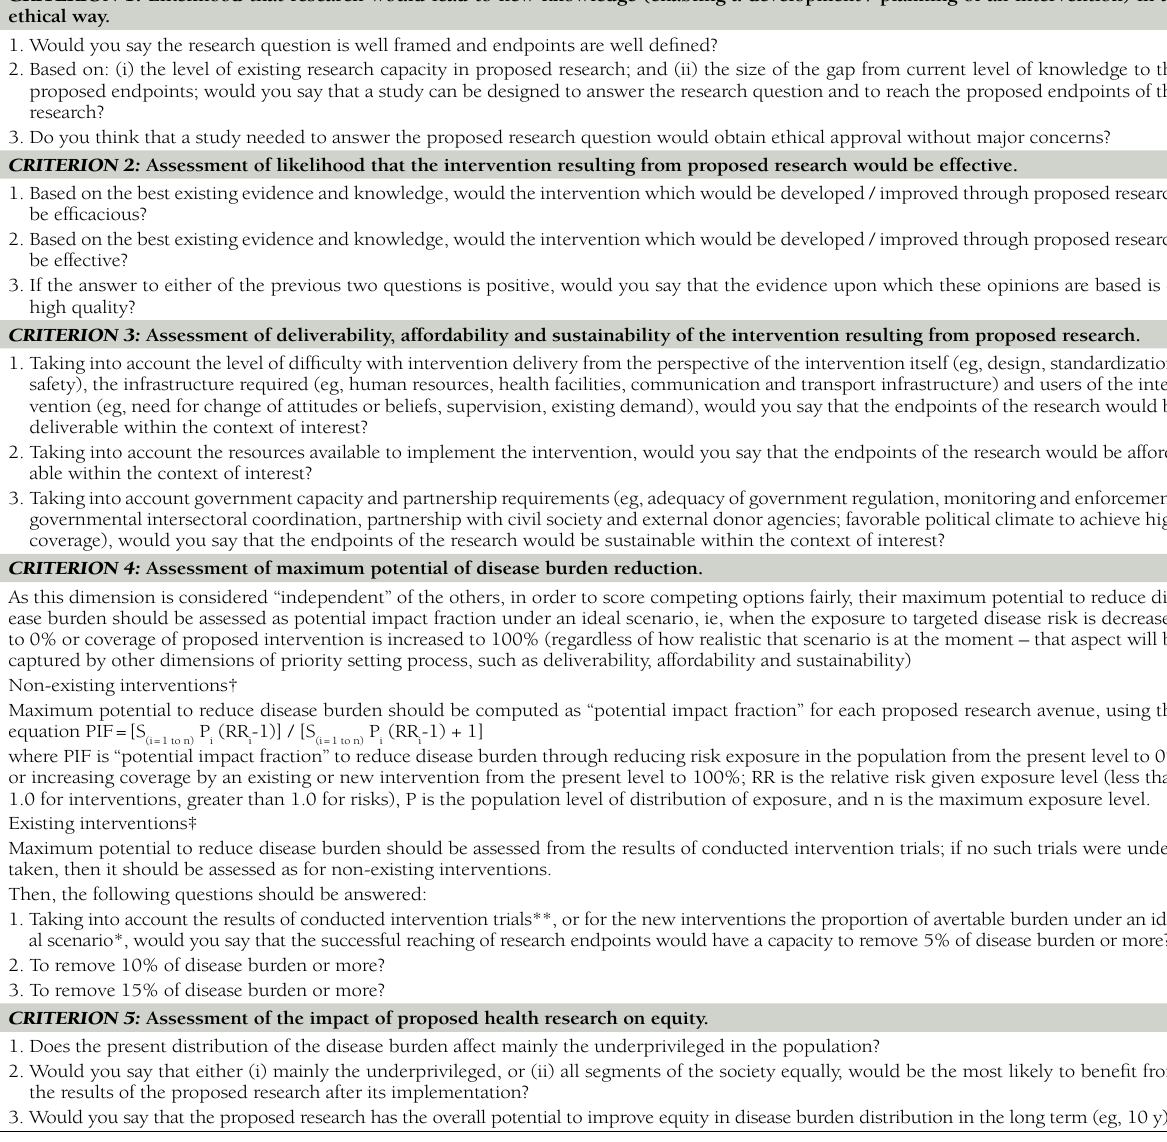
Table 2 Questions answered by technical experts to assign intermediate scores for each criterion to 82 competing research ideas* CRITERION 1: Likelihood that research would lead to new knowledge (enabling a development / planning of an intervention) in an ethical